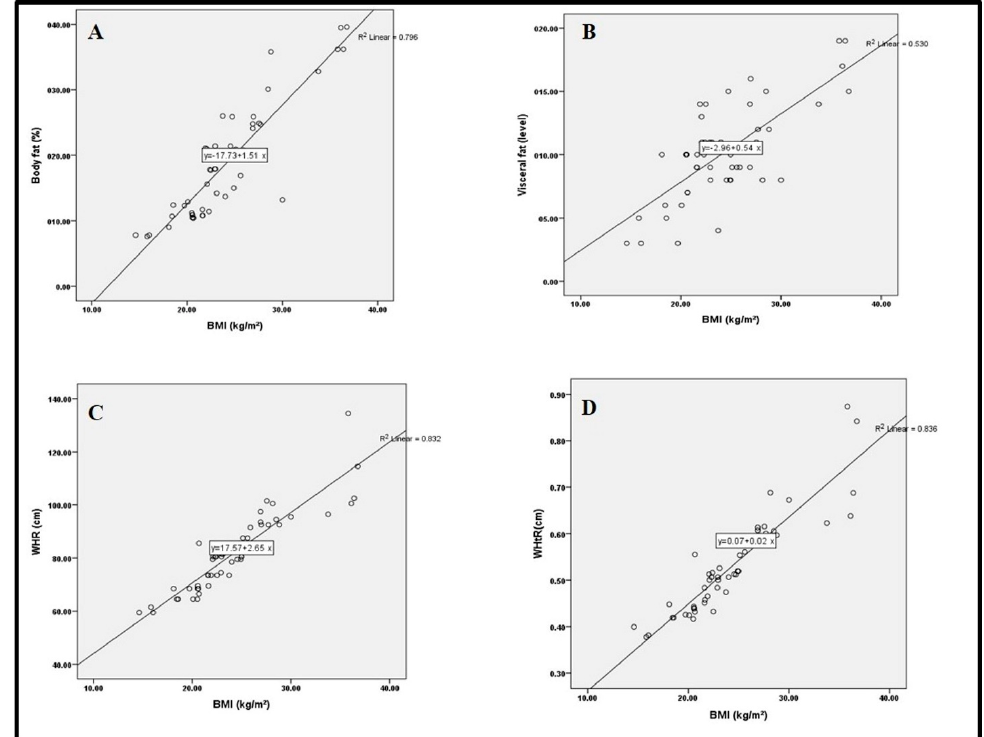
Figure 1. Regression models of (A) Correlation between body mass index (BMI) and percentage body fat in females with CD y= 17.73+ 1.51x, r 2 =0.796; (B) Correlation between body mass index (BMI) and level of visceral fat in women with CD y = 2.96+ 0.54x, r 2 =0.530; (C) Correlation between body mass index (BMI) and (WHR) in women with CD y= 17.57+ 2.65x, r 2 =0.832; (D) Correlation between body mass index (BMI) and (WHTR) in women with CD y = 0.07+ 0.02x, r 2 =0.836.